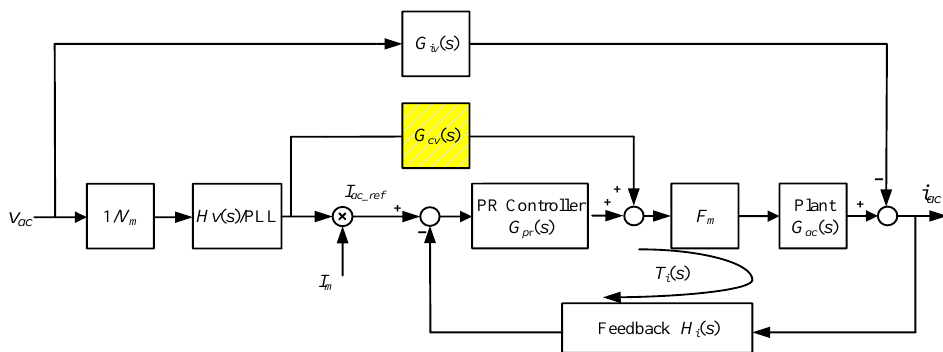
Figure 8. Control block diagram for the proposed H-bridge inverter.